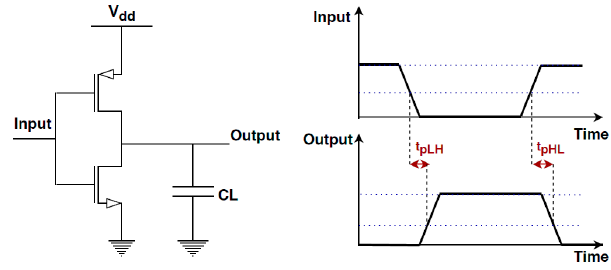
Figure 6. Inverter circuit and T PHL , T PLH parameters in response waveforms.